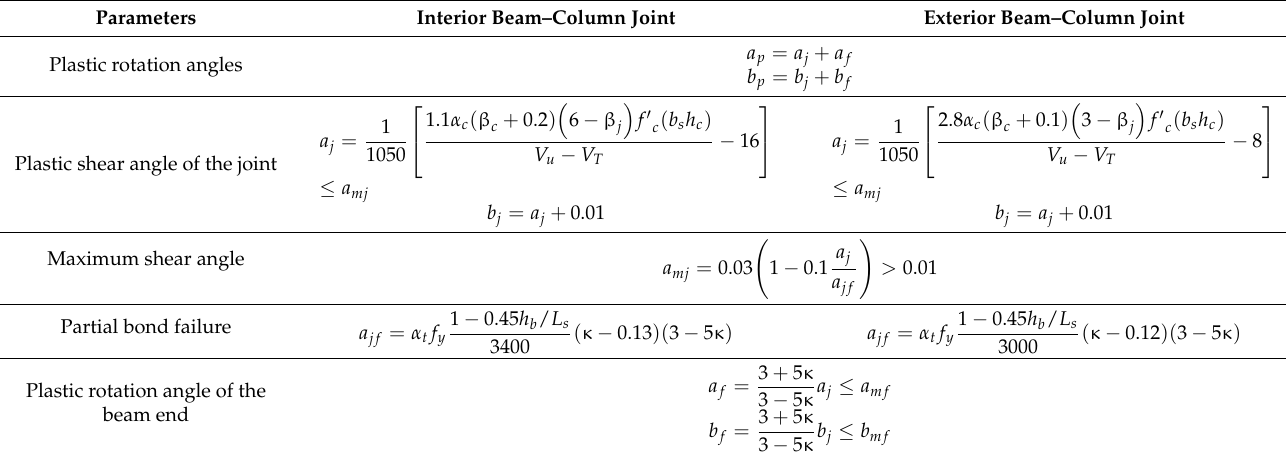
Table 1. Parameters for plastic rotation